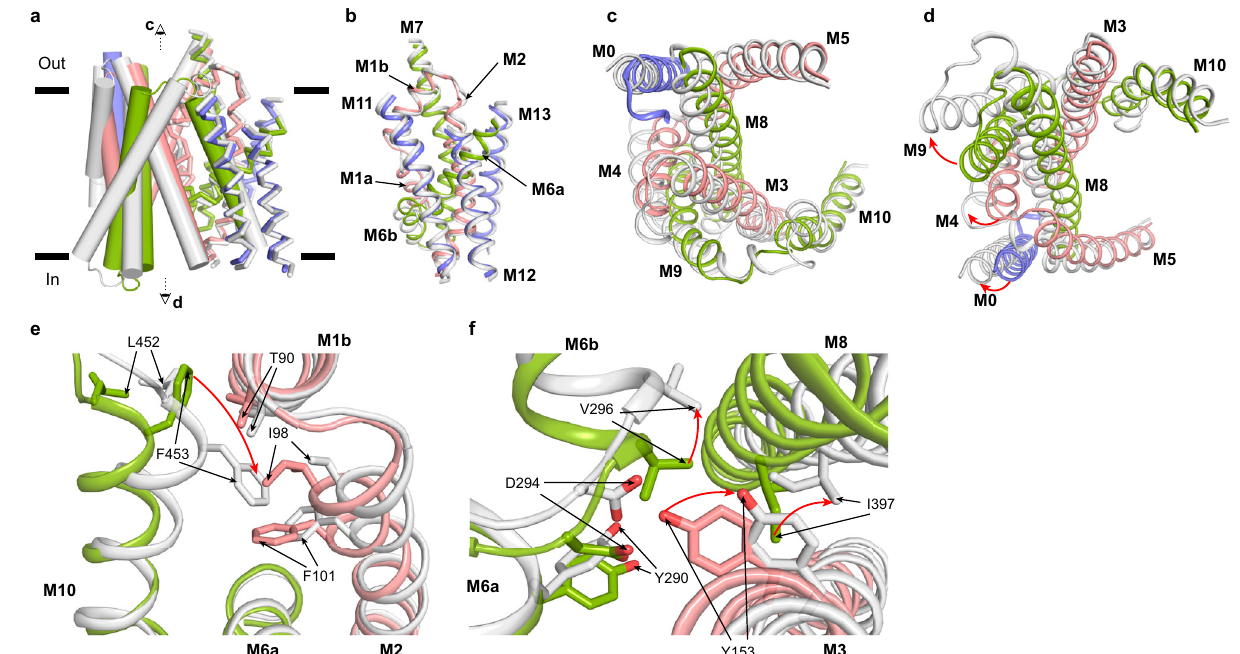
Fig. 6 | Conformational changes from outward-open to inward-open. a SuperpositionofhSGLT1 outward-oepn (colored)andhSGLT1 inward-open (gray,PDBID: 7SLA). Helices are shown as cylinders. b The structural alignment of the constant module. c Top view of the moving module. d Bottom view of the moving